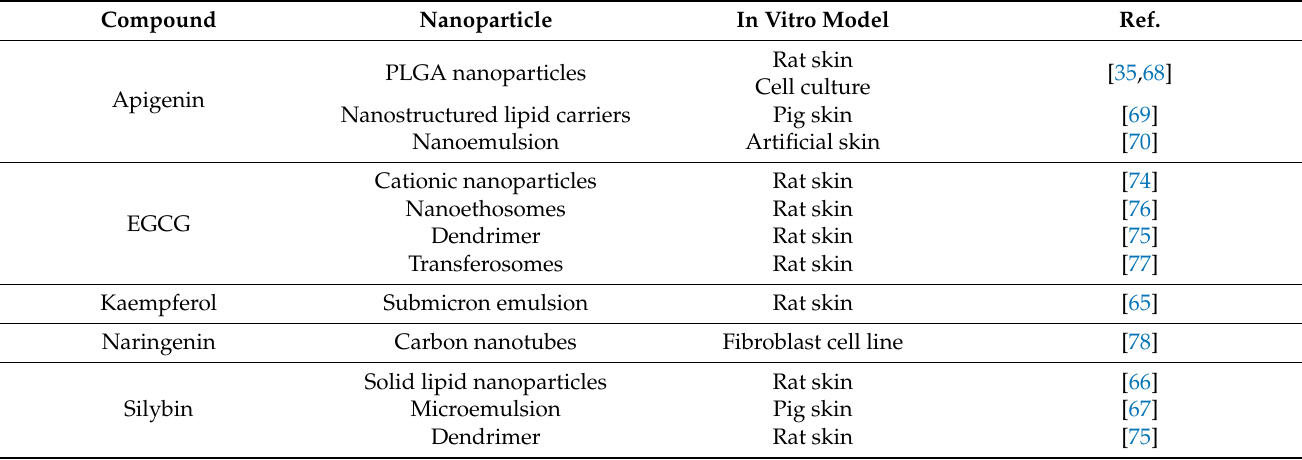
Table 2. The nanoparticles of different composition that have already been studied and proposed to encapsulate and deliver the selected flavonoids. The in vitro models where these nanoparticles were effective in delivering the indicated flavonoid are also indicated. In Vitro Model